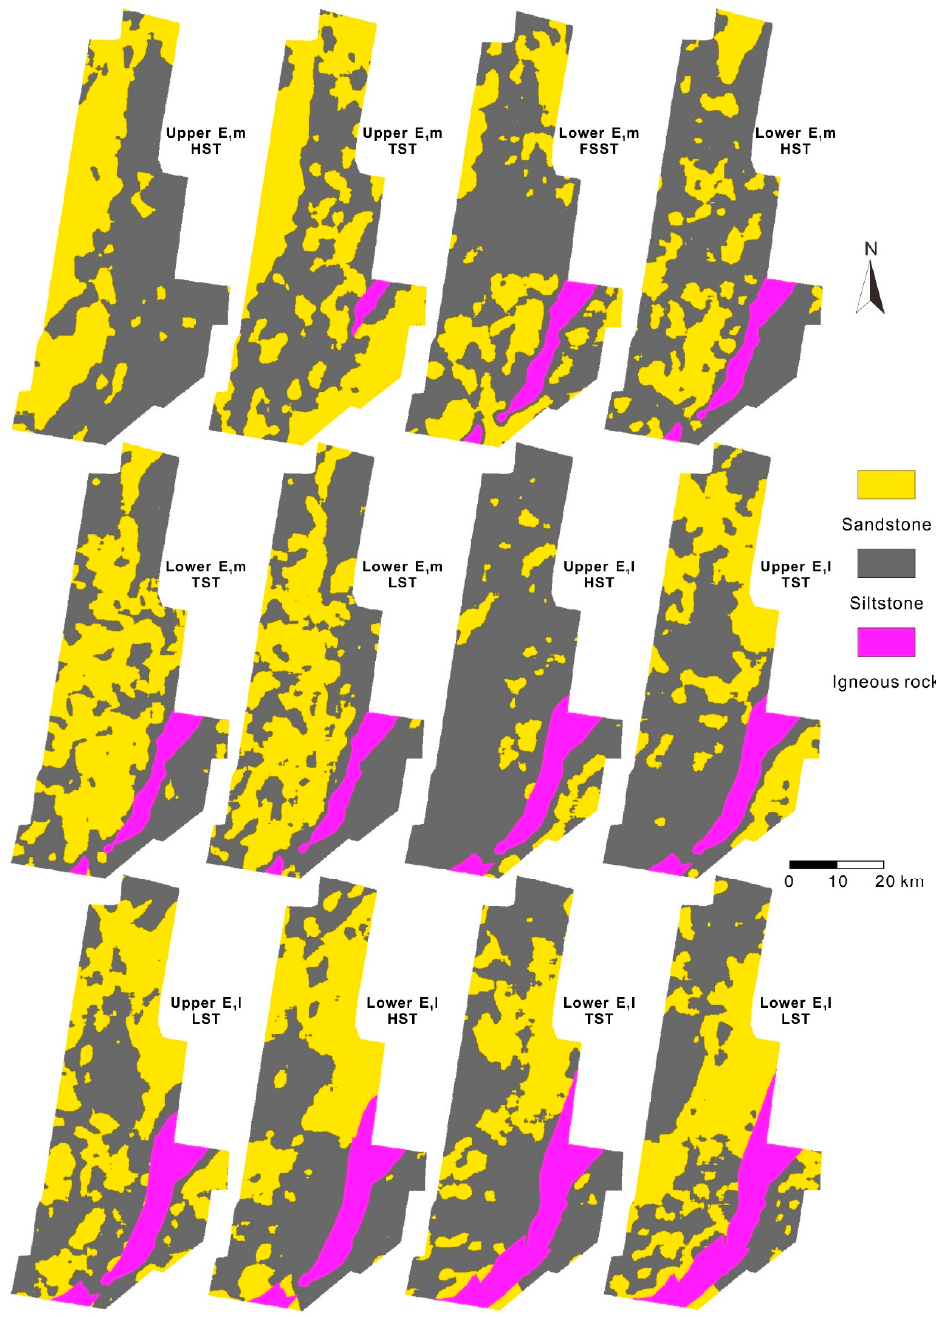
Figure 8. Distribution maps of the sandstone and siltstone of each systems tract in the reservoir interval. The purple areas represent the impermeable Lingfeng Uplift.